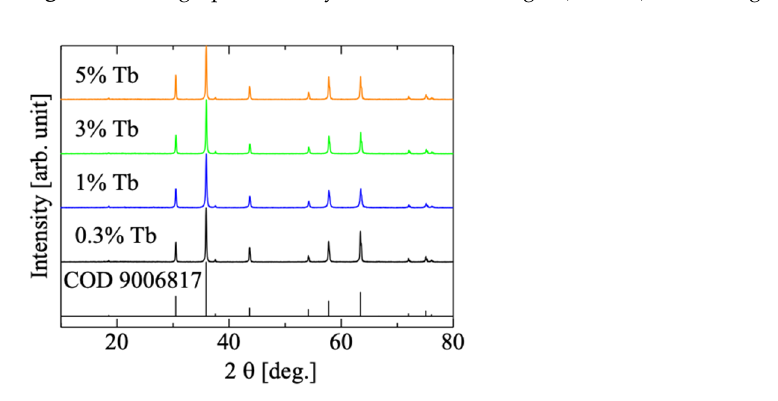
Figure 1. Photograph of the crystals under room light (bottom) and UV light (top).